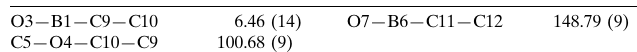
Selected torsion angles ( (cid:2) ).